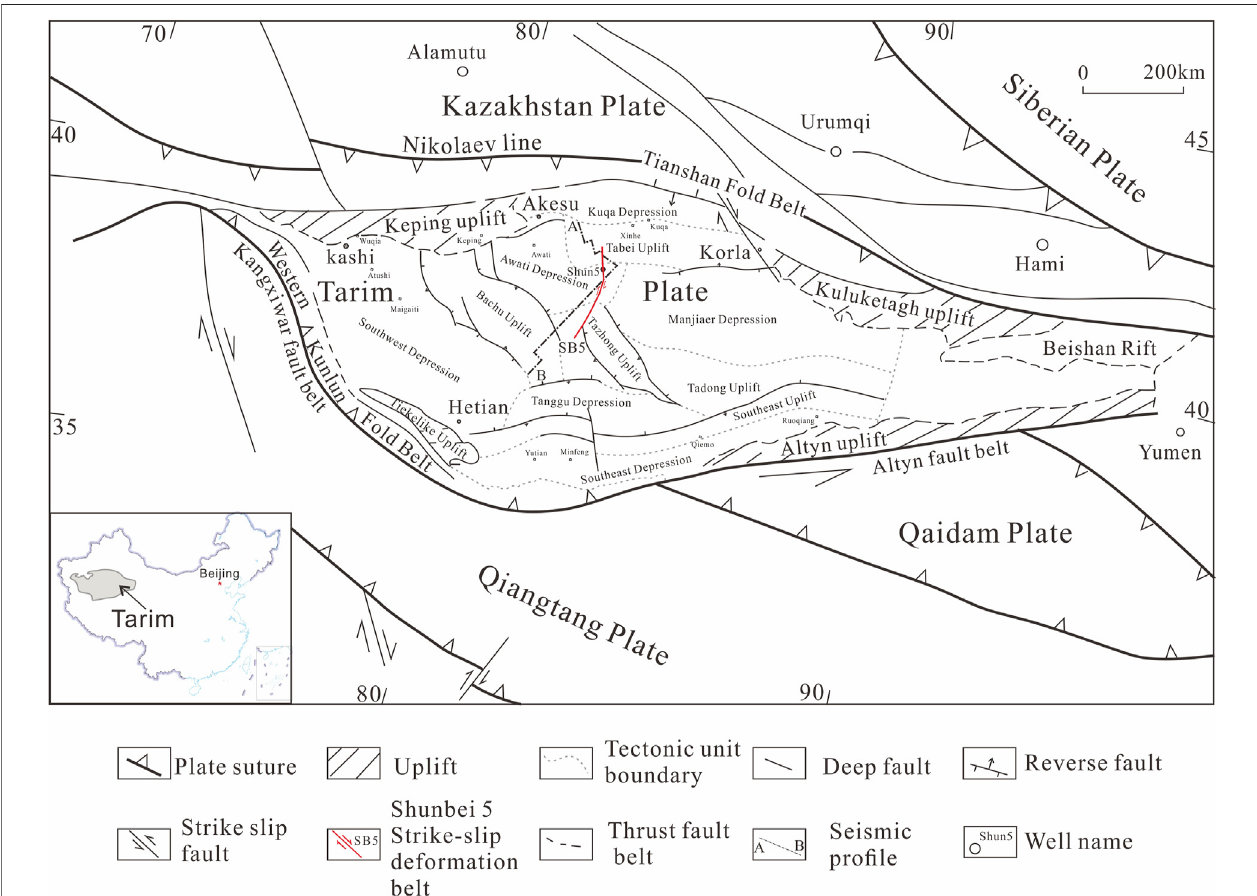
FIGURE 1 | Plate tectonics and tectonic units of the Tarim Plate (Basin).